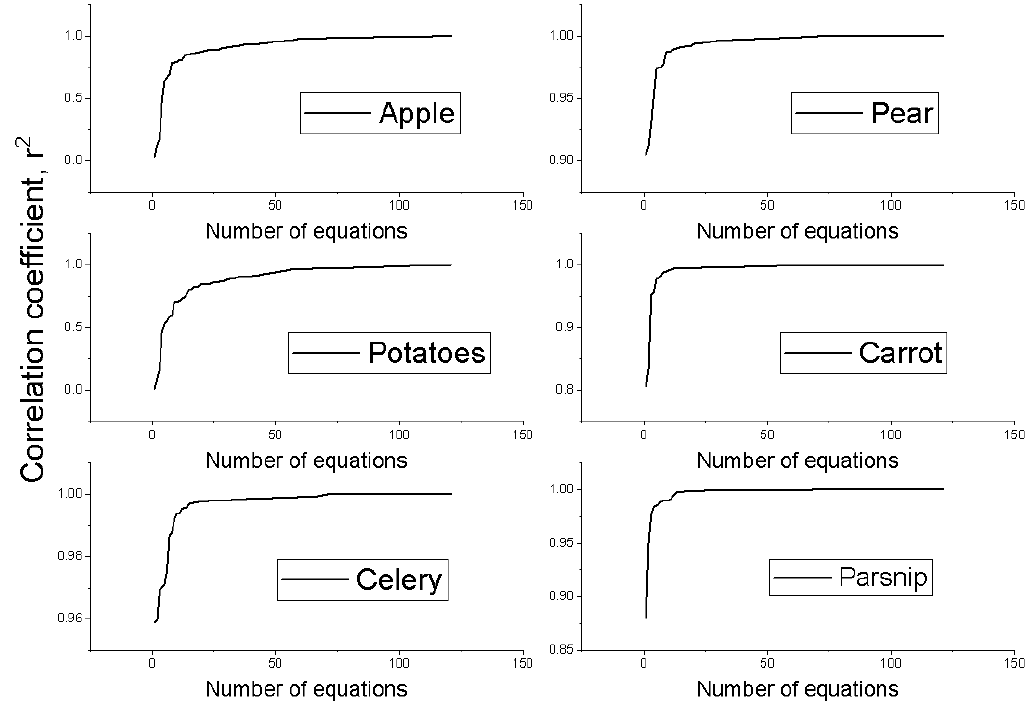
Figure 15. Variation of correlation coefficients for peeling products corresponding to common equations.